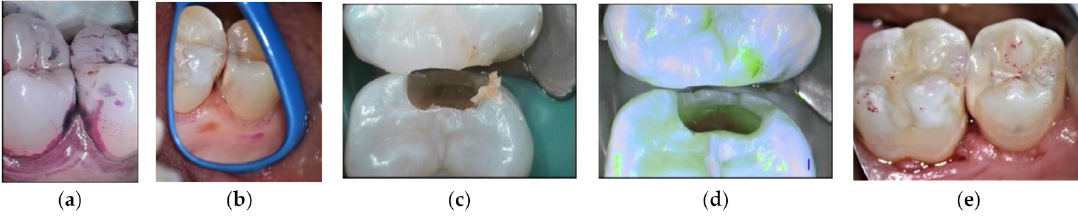
Figure 3. HCR patient treated with HV-GIC LC: ( a ) biofilm disclosing step; ( b ) visible cavitation after air flow cleaning; ( c ) cavity preparation; ( d ) fluorescence image after cavity preparation: red signal of the leathery dentine (Soprolife TM image); ( e ) HV-GIC LC